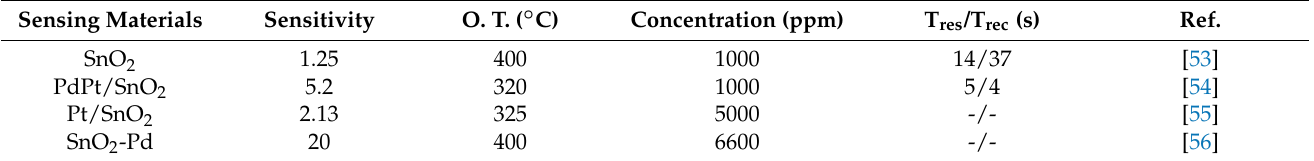
Figure 8. ( a ) The repeatability of Pd@In 2 O 3 -2 to 5000 ppm CH 4 ; ( b ) long-term stability of Pd@In 2 O 3 -2 sensor towards 5000 ppm CH 4 for 30 days. Table 2. Comparison of methane gas sensing properties of different materials from recent publica- tions.